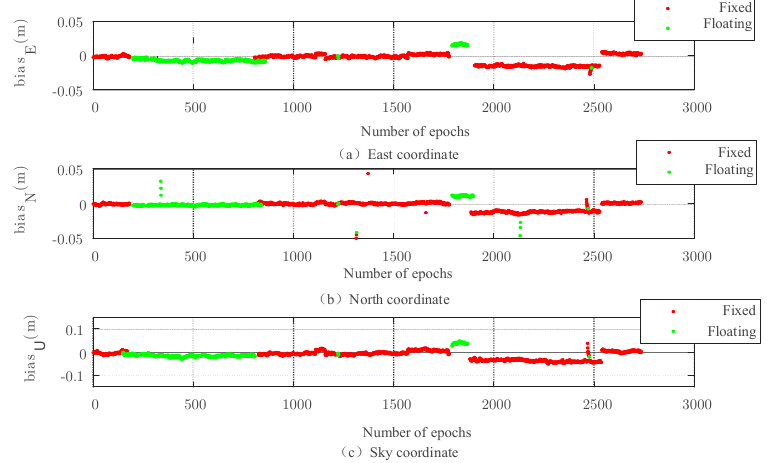
Figure 9. Three − dimensional baseline solution results of the conventional PAR algorithm based on the LAMBDA algorithm.